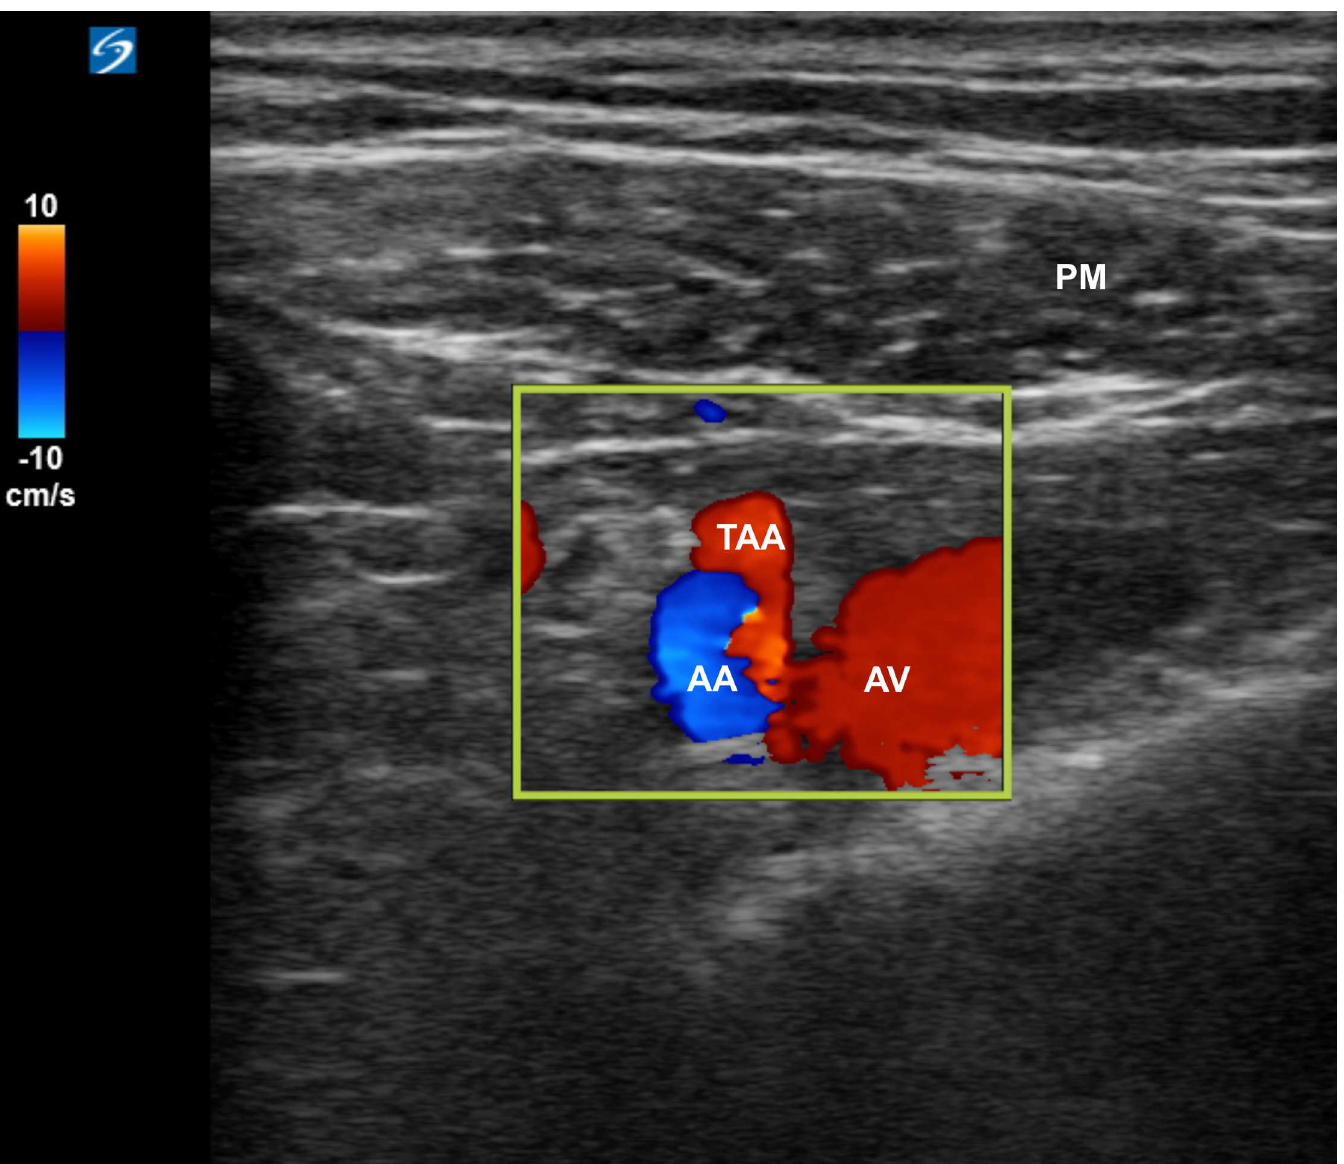
Fig 2. Ultrasound image of the thoracoacromial artery originating from the axillary artery. AA: axillary artery, AV: axillary vein, TAA: thoracoacromial artery, PM: pectoralis major muscle.